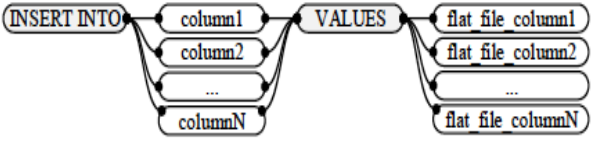
Fig. 6. Graph of an SQL statement.